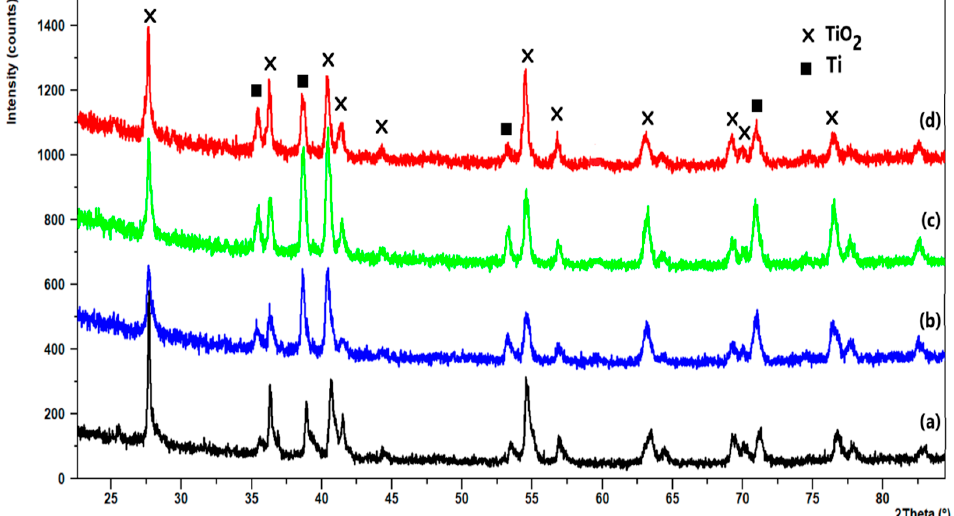
Figure 8 . XRD patterns for Zn/TiO 2 (a), Pd-Zn/TiO 2 with Pd/Zn = 0.2/0.05 (b), Pd–Zn/TiO 2 with Pd/Zn = 0.2/0.1 (c), and Pd-Zn/TiO 2 with Pd/Zn = 0.2/0.2 (d).